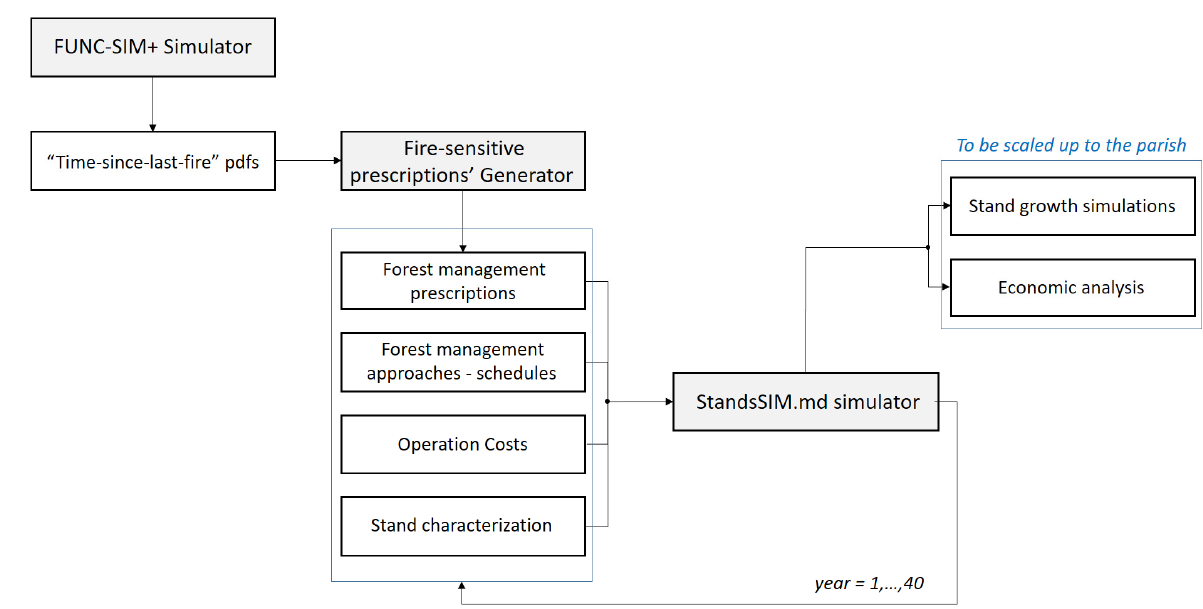
Figure 2. Outline for the integrated approach used consisting of developing a prescription generating tool to link the fire simulator outputs and the forest growth simulator inputs.